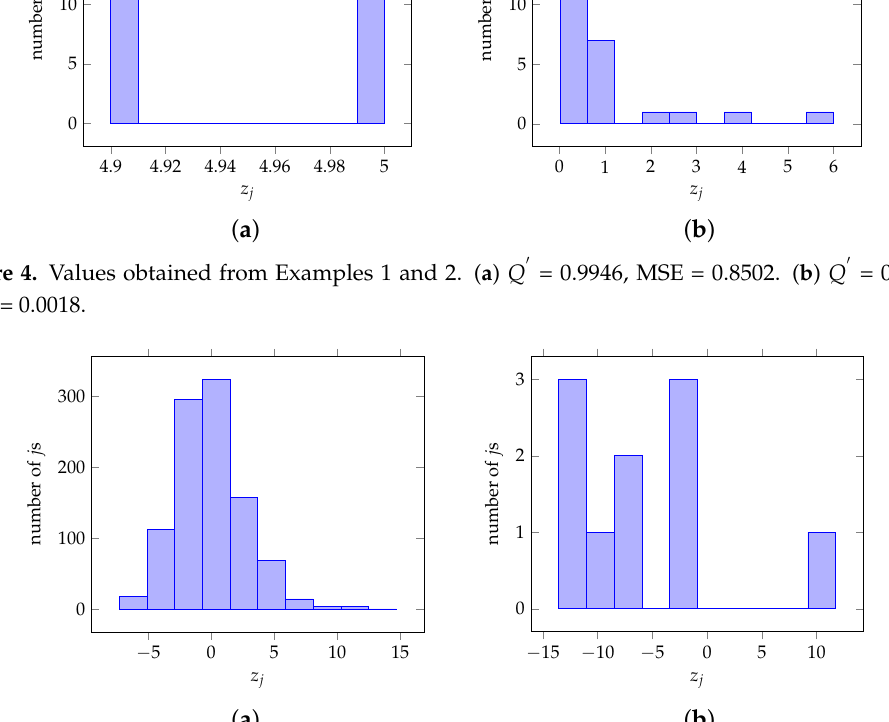
10 − 5 . ( b ) Q (cid:48) = 0.1111, ×